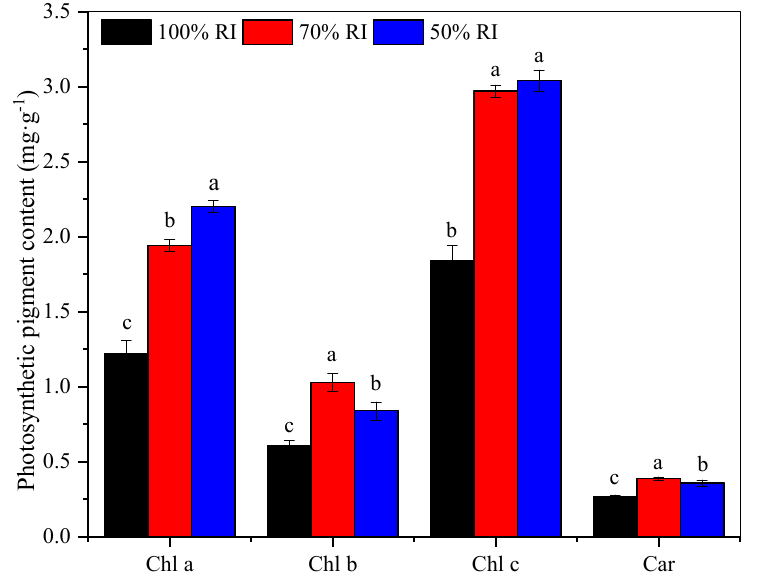
Figure 1. Photosynthetic pigment content in needles under different light treatments (means ± SDs), n = 6. Abbreviations: RI, relative irradiance; Chl a, chlorophyll a; Chl b, chlorophyll b; Chl c, total chlorophyll; Car, carotene. Significant differences are indicated by different lowercase letters: p <